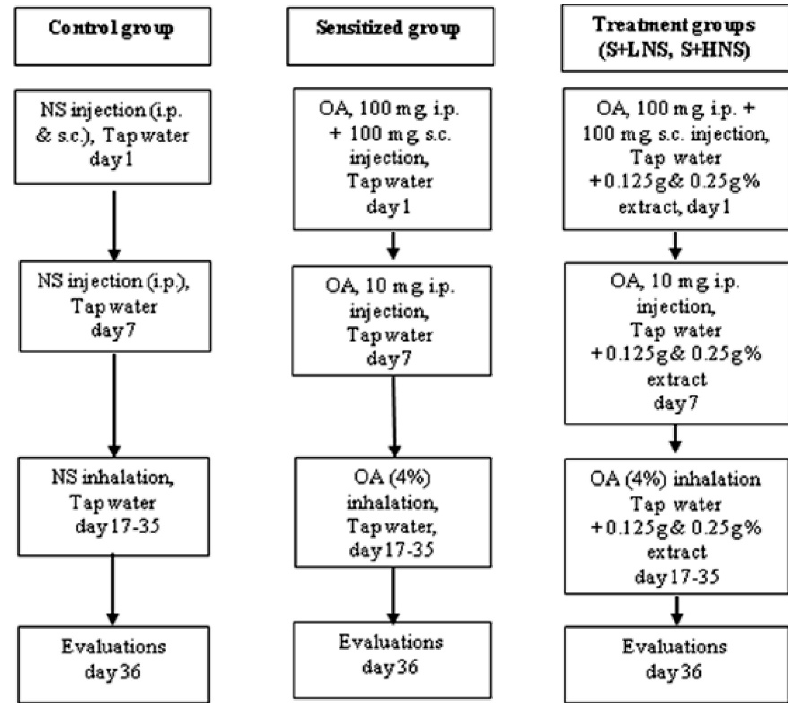
Figure 1 - Experimental timeline for the control, sensitized and treatment